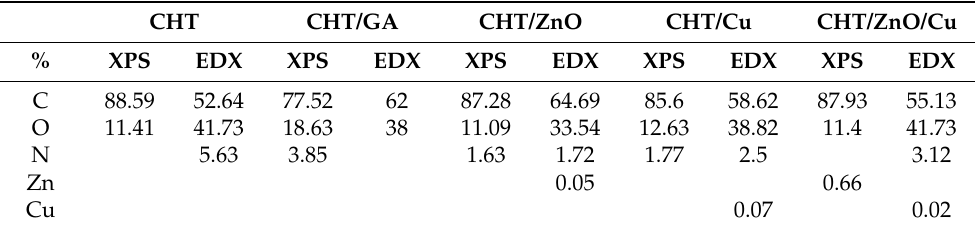
Table 3. XPS and EDX atomic percentage of C, O, and N of chitosan films crosslinked with GA and mixed with Zn-O and Cu.